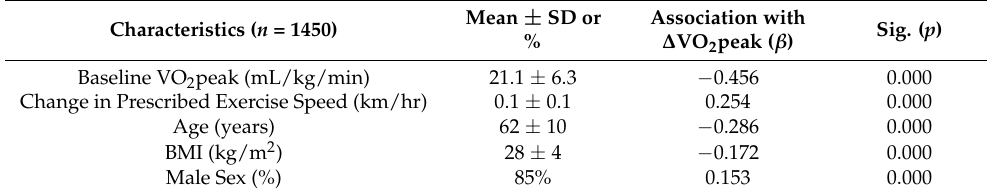
Table 3. Factors associated with greater relative improvements in cardiorespiratory fitness among all Coronary Artery Disease (CAD)